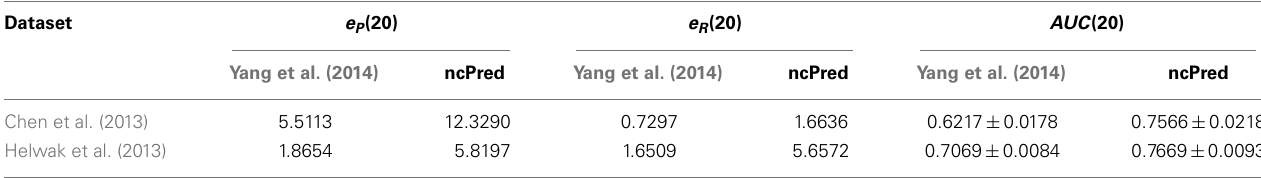
Table 2 | Comparison of ncPred andYang et al. (2014) through the precision and recall enhancement metric, and the average area under ROC curve (AUC) calculated for each of the two datasets listed inTable 1 .